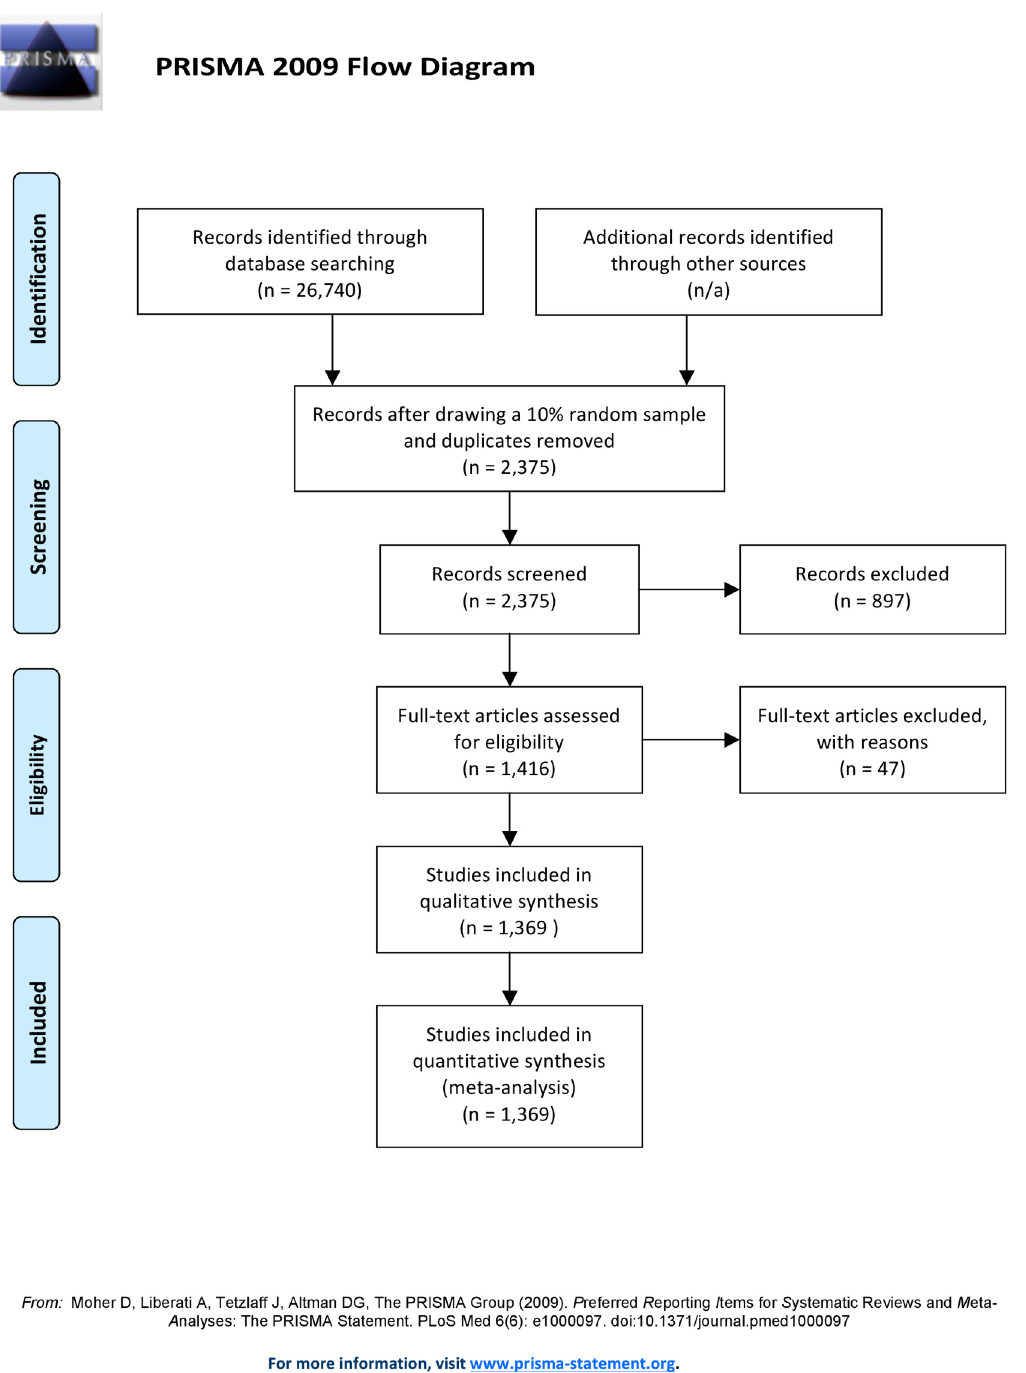
Fig 1. Flow chart for inclusion of studies. PRISMA flow chart of the results from the performed search strategy and selection